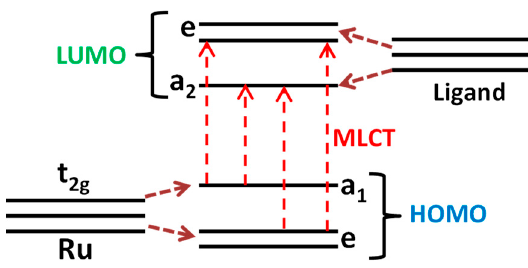
Figure 3. Energy level scheme of the molecular orbitals of Ru (II) heterocyclic complex. The four possible metal-to-ligand charge transfer (MLCT) states are indicated by the vertical arrows.